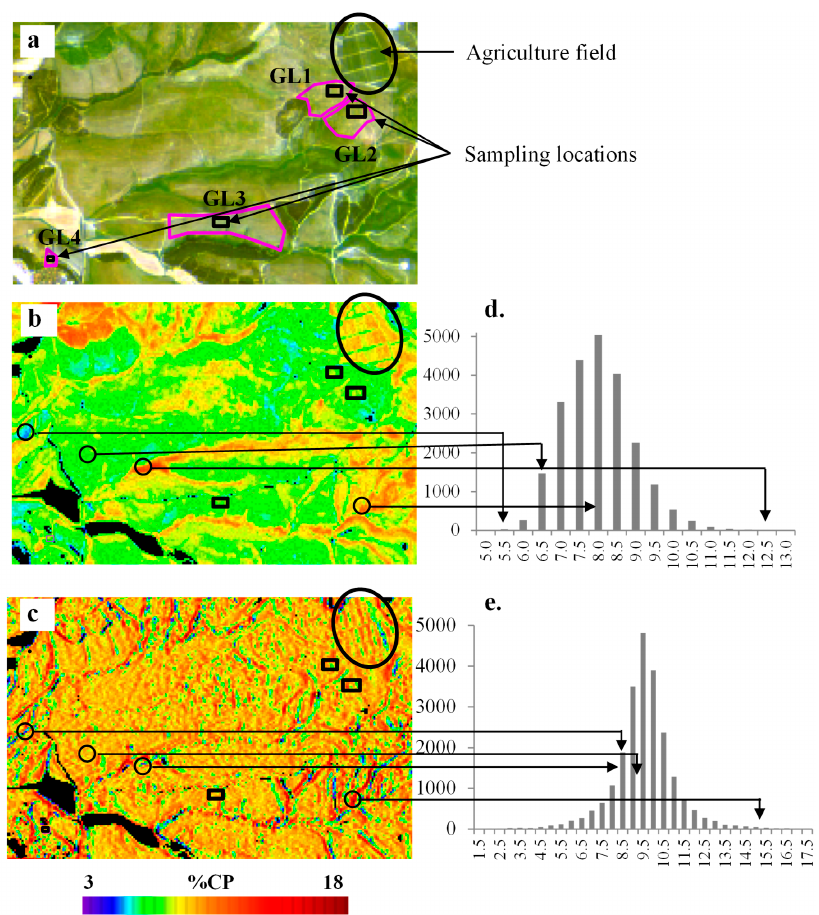
Figure 8. Visual and quantitative differences between two models applied to a Sentinel-2 image: the reflectance model (selected best model) and the first derivative (FD) model. a. True color of the study area. The magenta-bounded areas are the study plots (GL1–GL4), and the black rectangles indicate the sampling locations in each plot. b. Estimated CP map generated from the reflectance model c. Estimated CP map generated from the FD model. Note the increased noise level in c., d./e. Frequency distribution of the estimated CP values for all pixels in the study area, using the reflectance-based model (d) and the FD-based model (e). The black ellipse shows a wheat field as an example of CP variability within an agricultural plot. Note that the reflectance model makes the visual interpretation of CP values much easier than does the FD model.